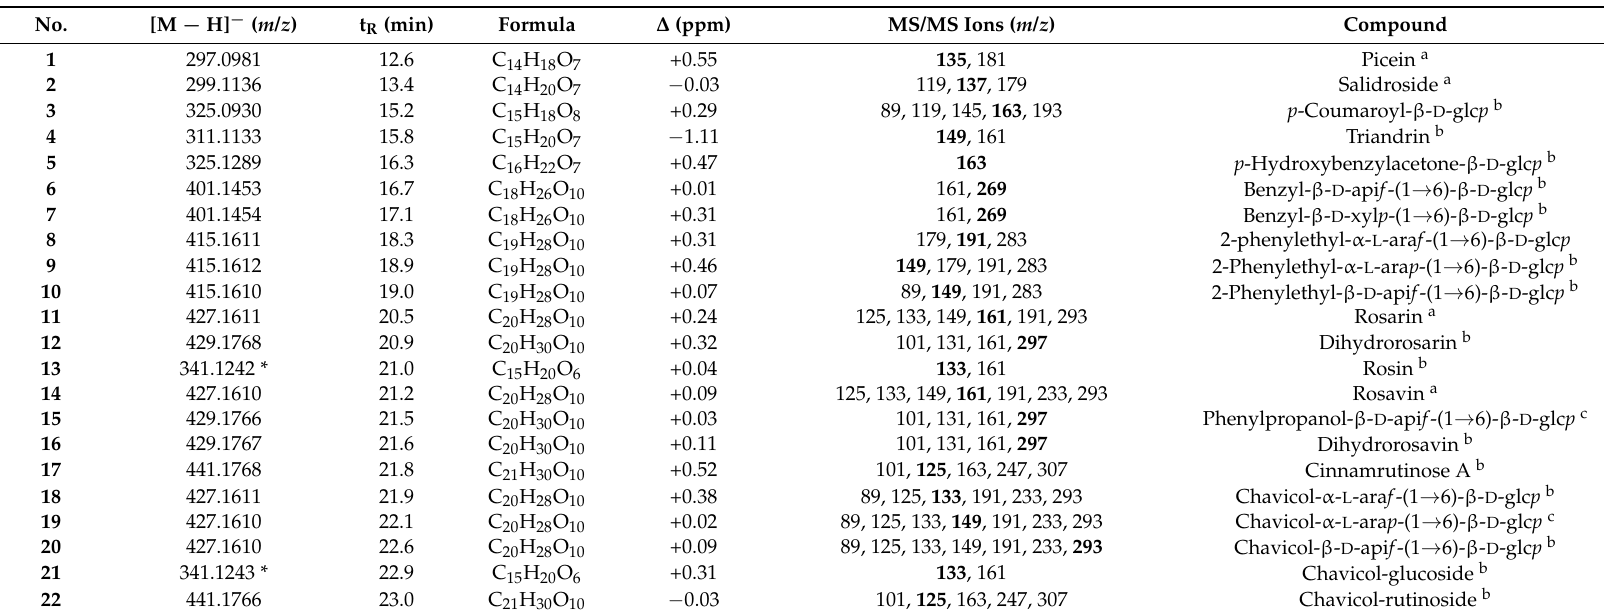
Table 1. Phenylalkanoid glycosides identified in the hydroalcoholic extract of Salix triandra × dasyclados (NWC1283) wood chips.